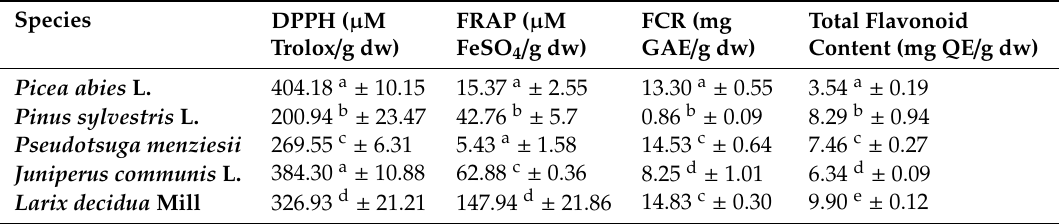
Table 3. Radical scavenging and antioxidant properties of tested conifers shoots using spectrophotometric methods.